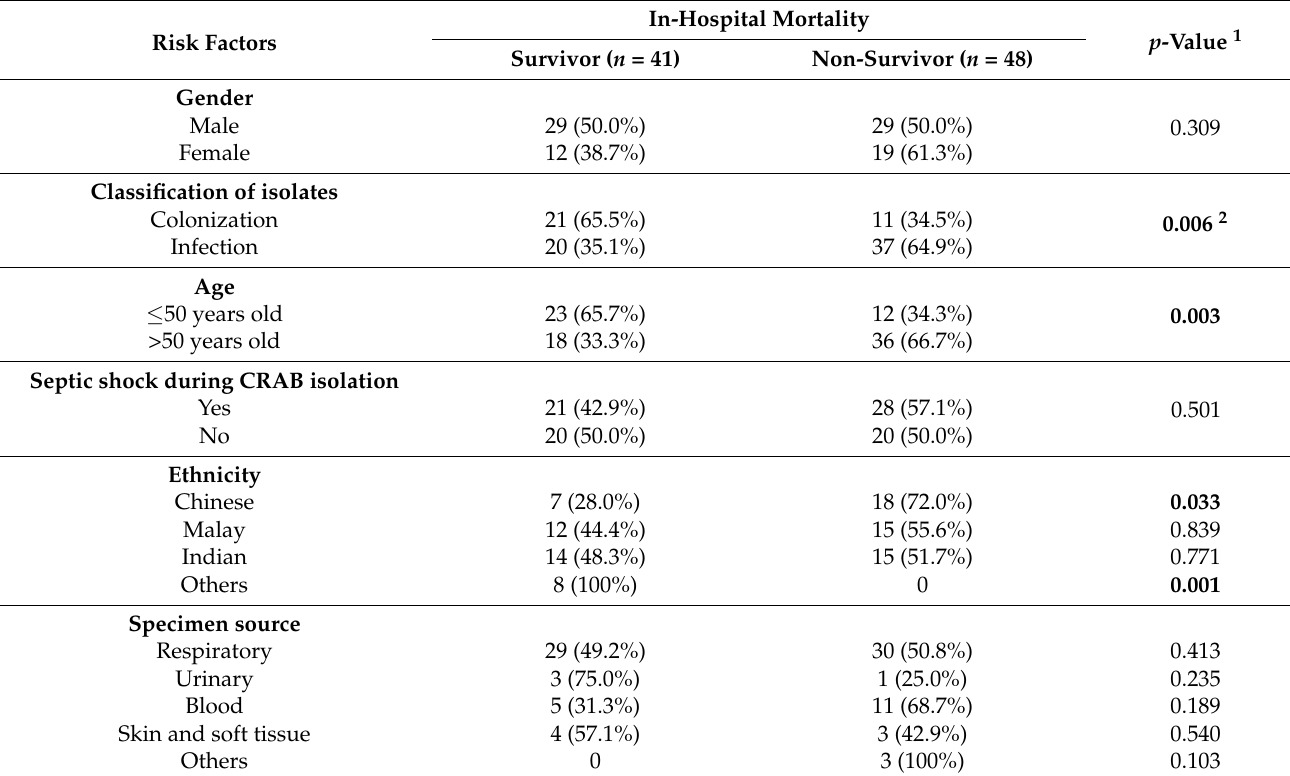
Table 1. Univariate analysis of the clinical characteristics of patients with CRAB who survived and did not survive. Risk